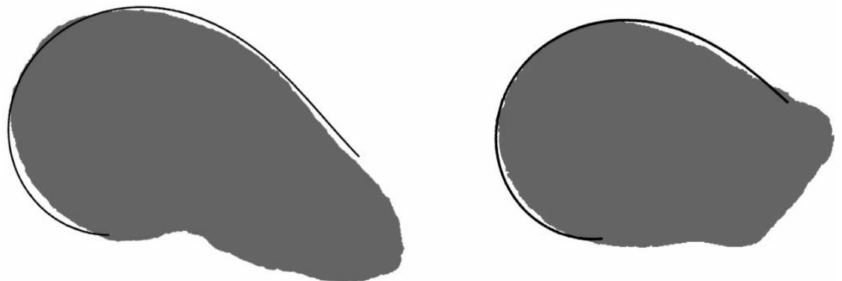
Figure 11. Graphic representation of the method used to draw the model in Hylocereus undatus and Pachycerus pringlei seeds. The curve adjusting to the seed profile is superimposed to the average sil- houette. The fragment of the seed image uncovered by the curve is completed with the corresponding fragment of the average silhouette with Corel Photo